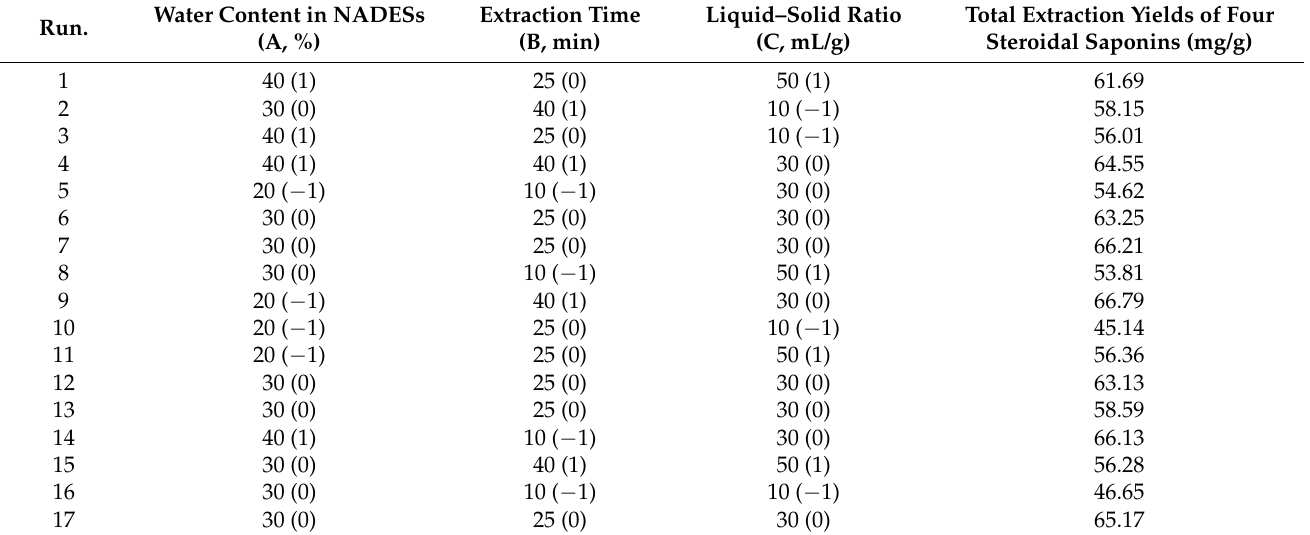
steroidal saponins were set as the response of the design experiments. The experimental orders, levels of variables, and response values are summarized in Table 3. Table 3. The experimental orders, levels of variables, and response values in Box–Behnken design. Run.